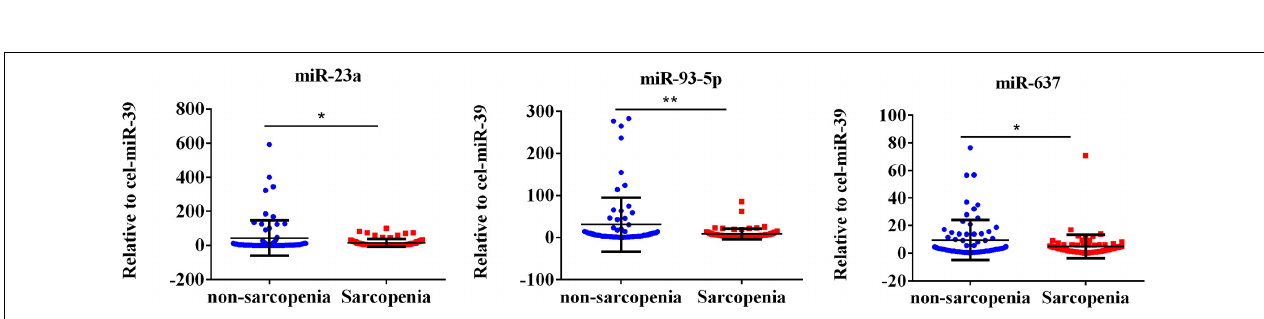
FIGURE 2 | Fracture risk-associated circulating miR-23a-3p, miR-93-5p, and miR-637 decrease in response to sarcopenia in the elderly. The expression level of microRNAs (miRNAs) were normalized using spike-in cel-miR-39. Unpaired t -test was used for these data. *Compared to non-sarcopenia of the elderly; * P < 0.05, ** P < 0.01; n =